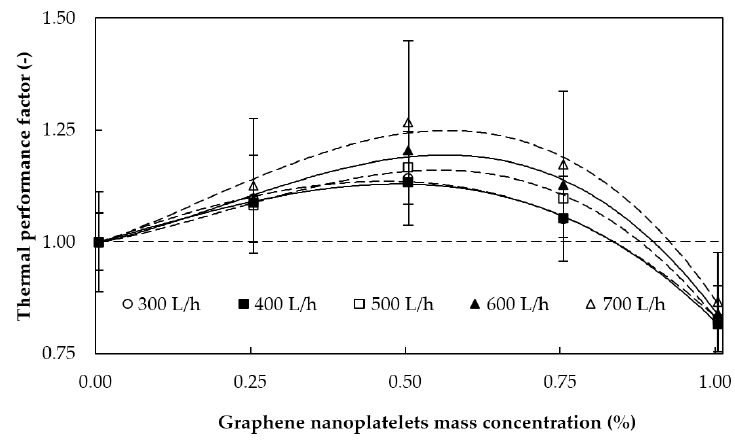
Figure 11. Thermal performance factor against graphene nanoplatelet concentration at 30 °C, with LMTD of 10 °C between fluids, for different flow rates.